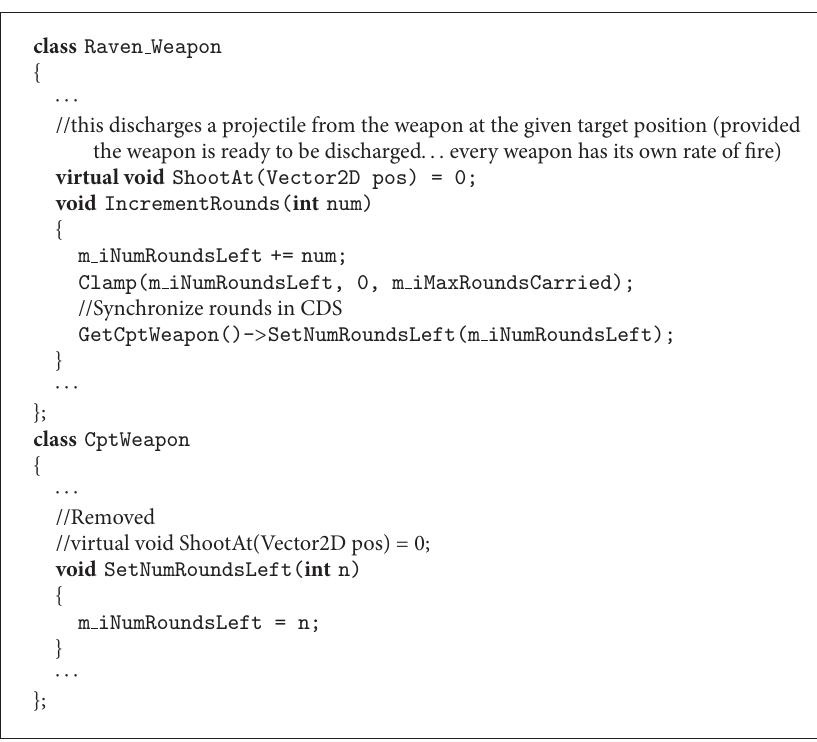
Algorithm 8: Modifications in the conceptual copy of a Raven class. No game behavior is defined in CDS, which hosts nothing more than a projection of the game state.